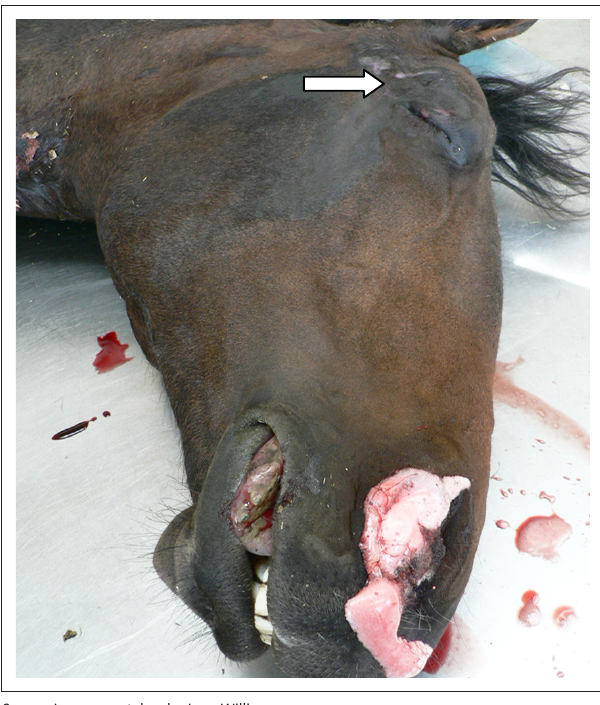
FIGURE 1: Head of lineage 2 West Nile virus-infected Case 3 demonstrating oedema of the supraorbital fossa (arrow) and blood-tinged foam at nostrils.